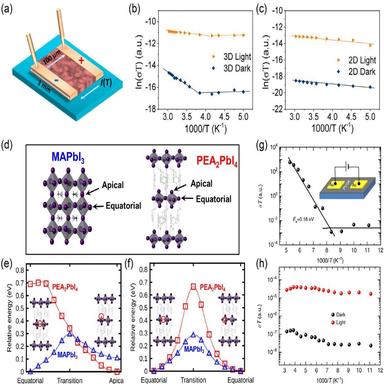
Temperature-dependent conductivity measurement geometry (a) and the results of MAPbI3 (b) and (BA)2(MA)3Pb4I13 (c) polycrystalline films . Copyright 2017, American Chemical Society. (d–f) Energetics of iodide vacancies in MAPbI3 and PEA2PbI4 during different migration paths using DFT calculations. Copyright 2017, American Chemical Society. Temperature-dependent conductivity of a bare FAPbI3 film (g) and with 1.67 mol% 2D PEA2PbI4 perovskite (h). Copyright 2018, Springer Nature L